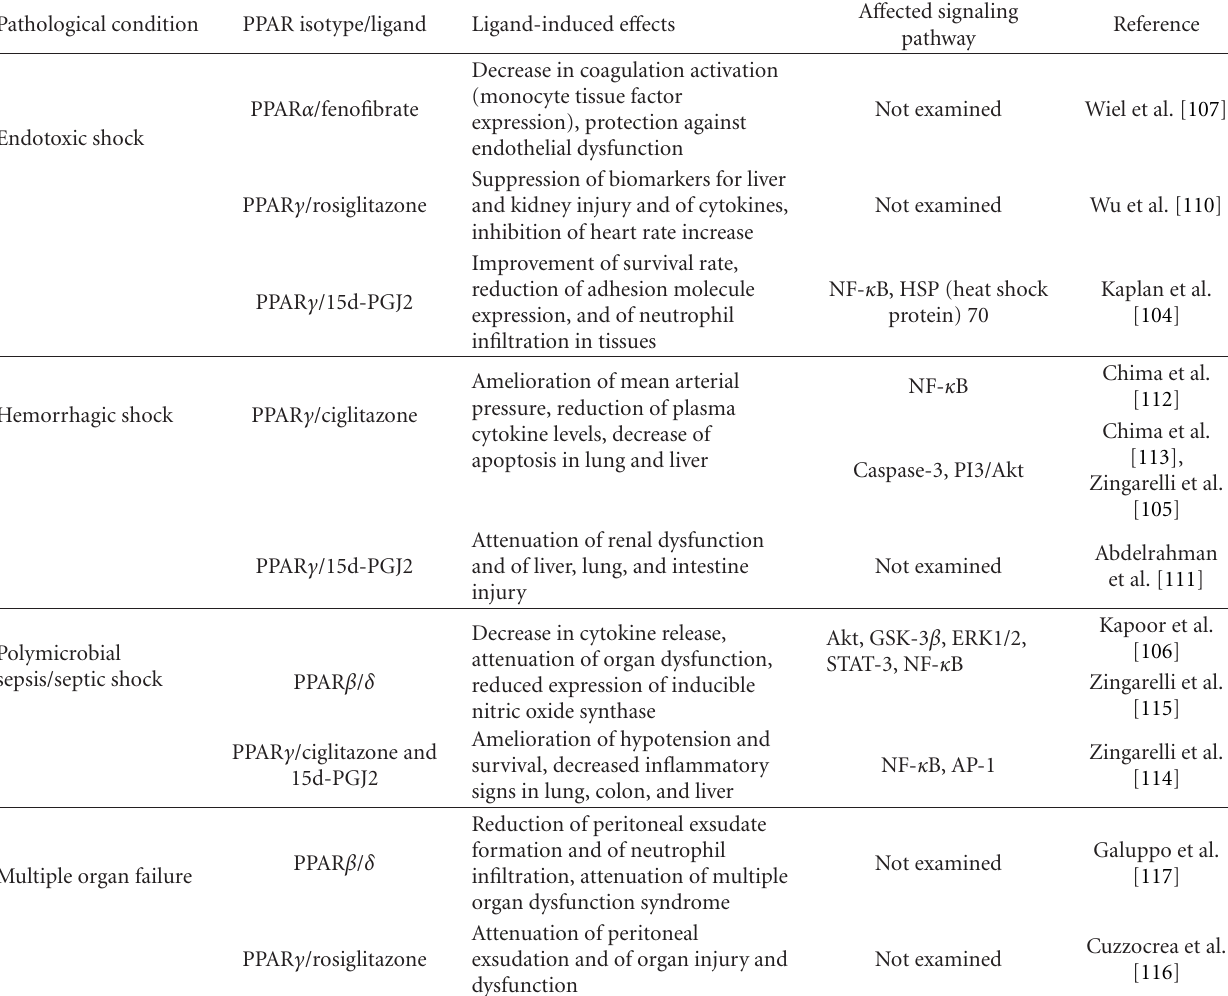
Table 1: Selected publications on experimental studies testing the anti-inflammatory e ff ects of PPAR ligands in various models of sepsis and